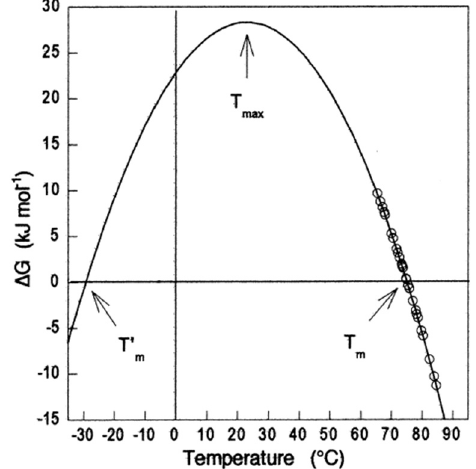
Figure 10. Stability curve, ∆ G N vs. T , of β -lactoglobulin B from CZE at different temperatures in 100 mM sodium phosphate, pH = 6.2. T’m and Tm are the transition temperatures corresponding to cold- and heat-induced unfolding. Data were fitted according to the Gibbs–Helmholtz equation (Equation (44)). Reproduced from [227] with permission from